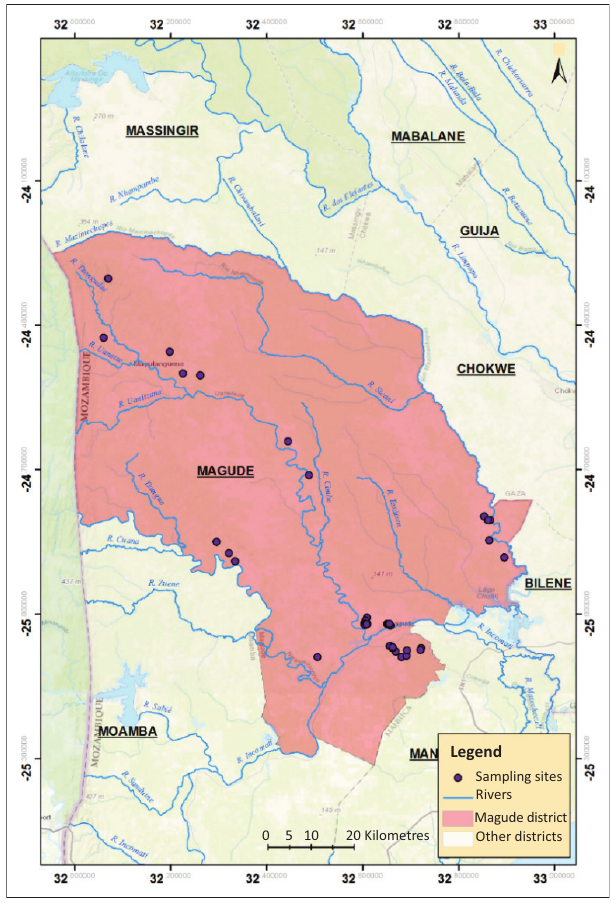
FIG URE 1: Map of Magude District and localities where dog and livestock samples were